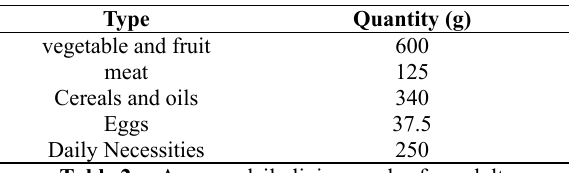
Table 2. Average daily living needs of an adult